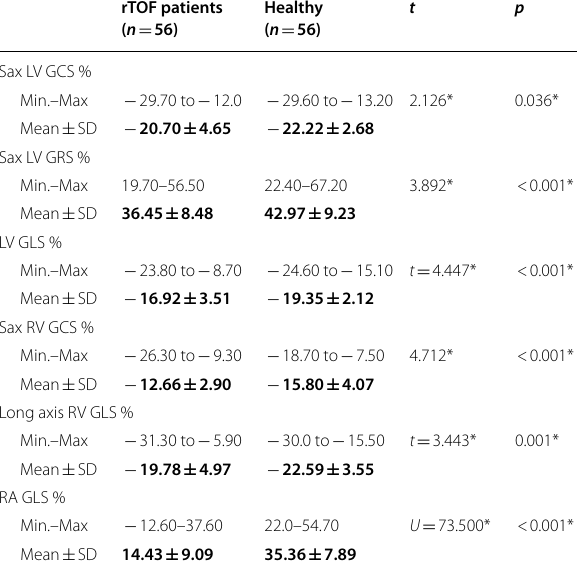
Table 10 Correlation between different conventional and advanced feature tracking right atrial and right ventricular parameters among the studied 56 rTOF patients